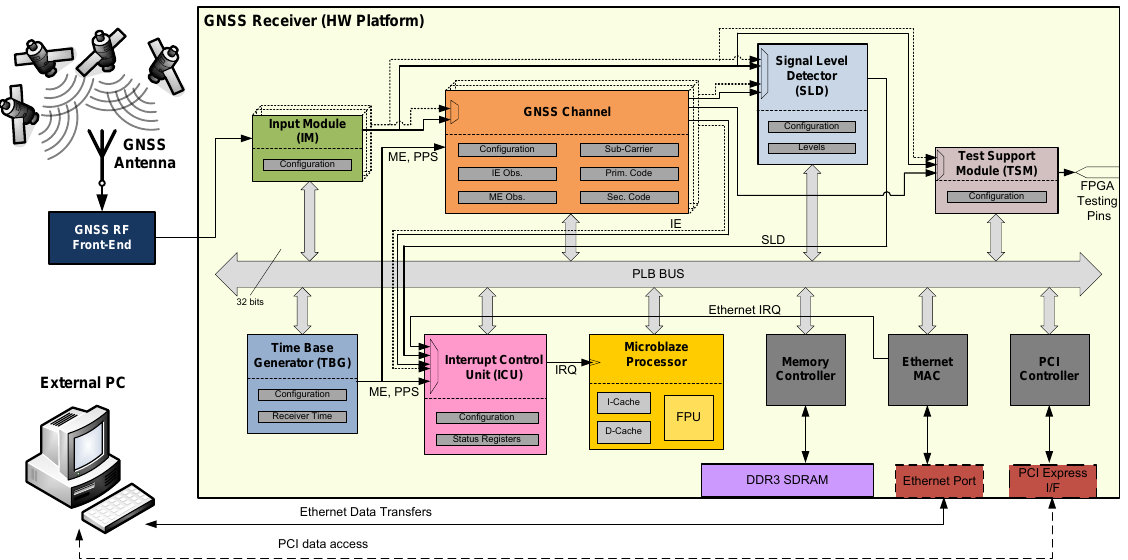
Figure 4. High-level architecture and interfaces of the Rx Core